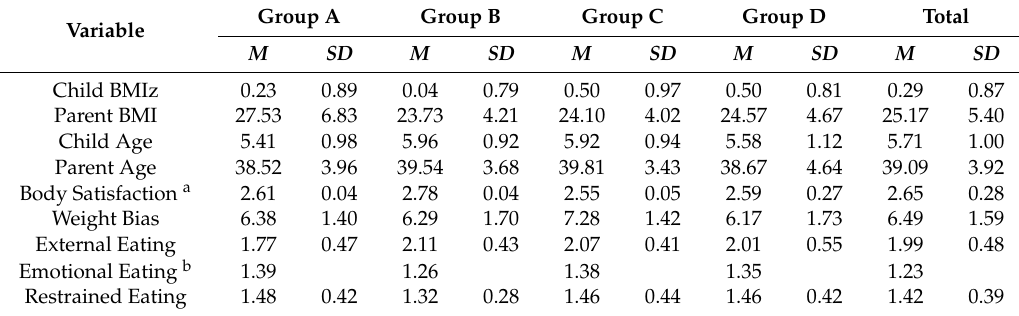
Table 1. Descriptive statistics for age, BMI and child outcome variables.